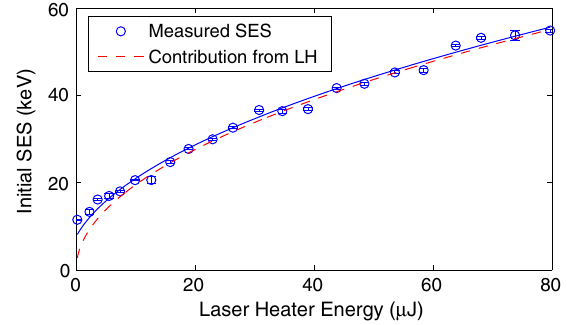
FIG. 20. Initial SES following the laser heater as a function of laser heater energy. Line shows a fit to Eq. (G1). Dashed red line shows the SES induced by the laser heater (LH), inferred from the fit. The deviation is due to the beam ’ s initial energy spread from the gun, the PW effect, and the TCAV0